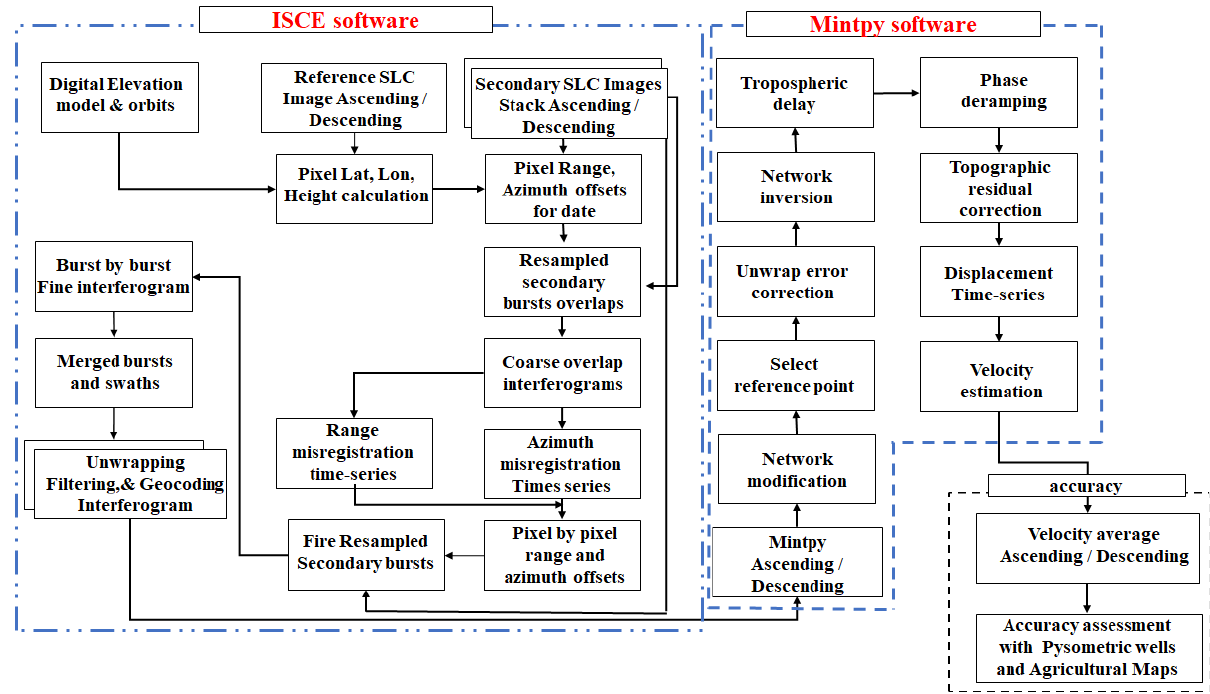
Figure 3. SBAS processing framework